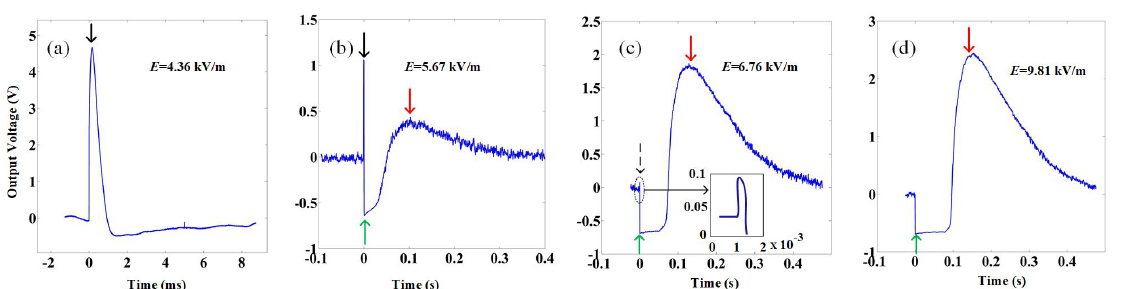
Figure 3. The measured output V ( t ) of the LiTaO 3 detector at four different values of E max , while the pulse duration is kept at 2200 ns. Panel ( a ) repeats the data of E max = 4.36 kV/m shown in Figure 2a. Panel ( b – d ) show the data of E max increased from 5.67 kV/m to 9.81 kV/m. The black arrows indicate that as E max is increased from 4.36 kV/m to 9.81 kV/m, the peak signal, which is expected with pyroelectric effects, is suppressed gradually. The green arrows indicate signals in opposite direction of the original peak develop as E max increases, and the red arrows mark the appearance and development of a new hump of V ( t ) at large E max